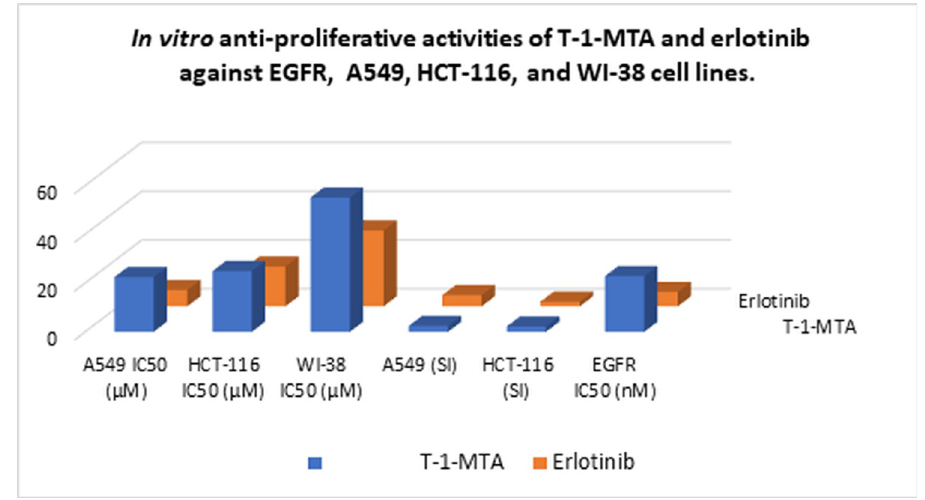
Fig 18. In vitro anti-proliferative and safety assessments of T-1-MTA and erlotinib.